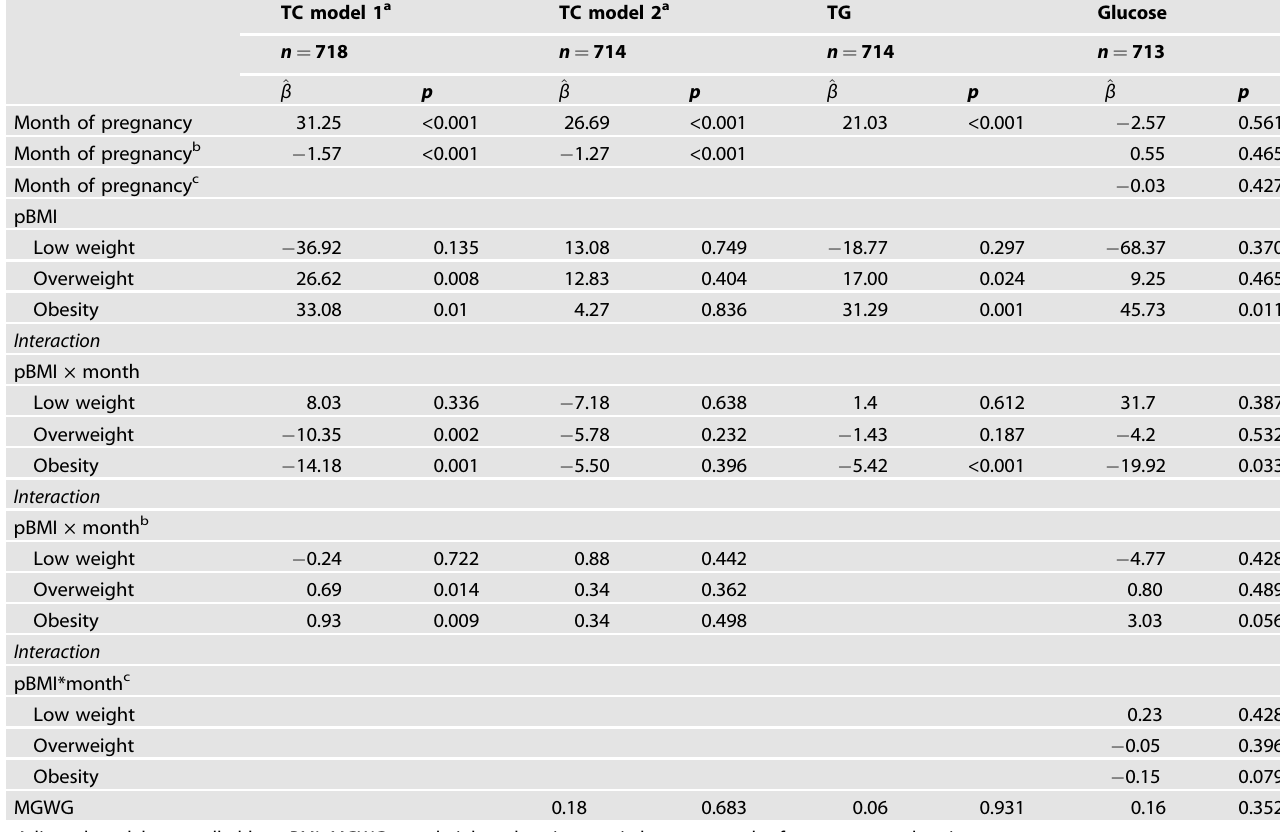
Table 2. Adjusted mixed model results for biochemical risk